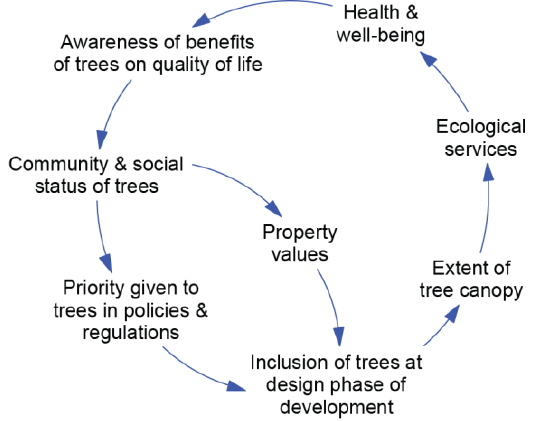
Figure 4. Health and Environment Sector Influence Diagram.